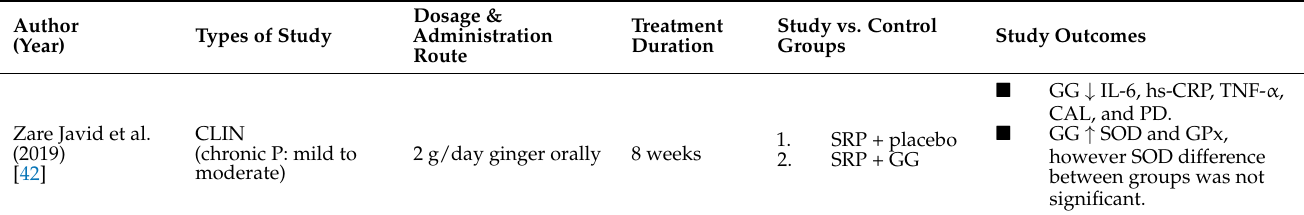
Table 8. Studies on the use of ginger (GG) in diabetes-associated periodontitis